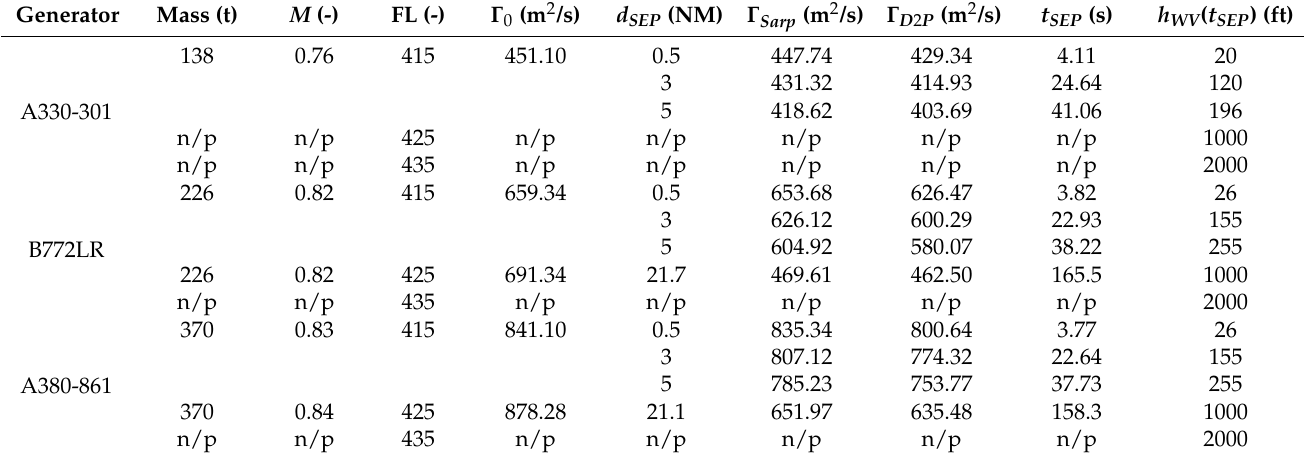
Table A2. Maximum circulations of wake vortex encountered by aircraft behind several generator aircraft in realistic scenarios at the ceiling of A330-301, and flight conditions of the generator.